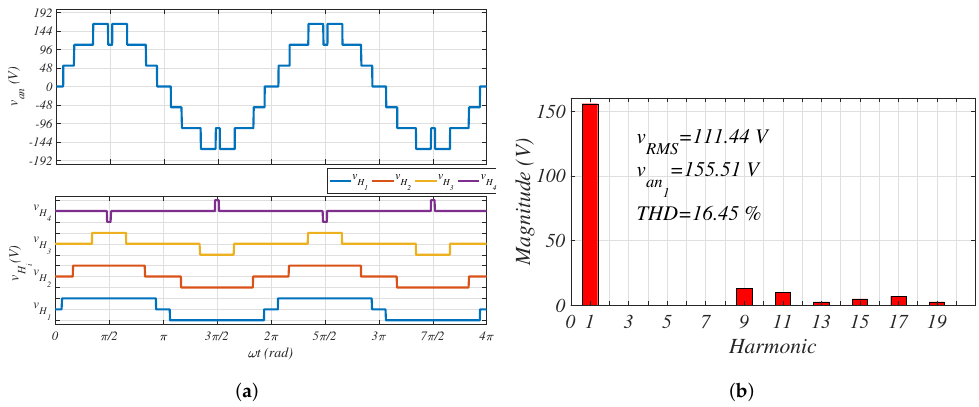
Figure 5. ( a ) Waveforms of v an , v H 1 , v H 2 , v H 3 , v H 4 when θ 4 > π /2, ( b ) Harmonics analysis of of v an when θ 4 > π